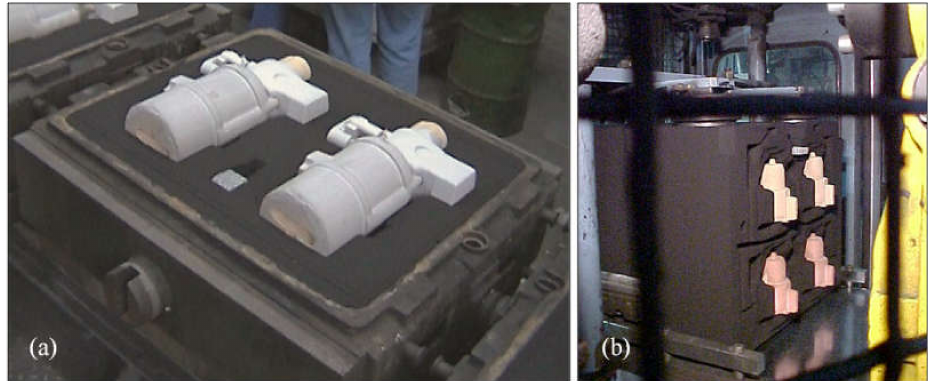
Figure 1. ( a ) Drag unit of a mold containing partially coated cores on a high-pressure horizontal molding line; ( b ) cores in a mold prepared using a high-pressure vertical molding